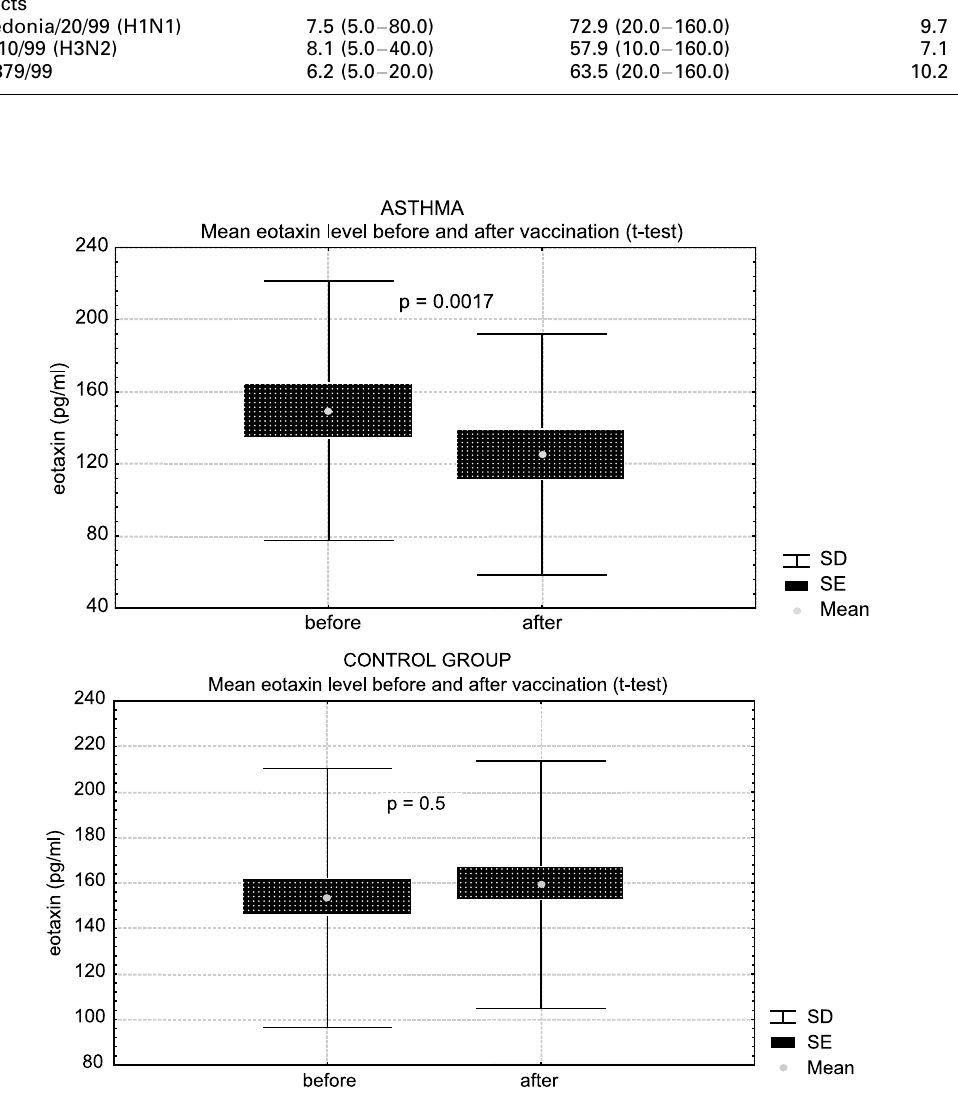
FIG. 1. Serum eotaxin level before and after vaccinations against influenza in both studied groups. SD, standard deviation; SE, standard